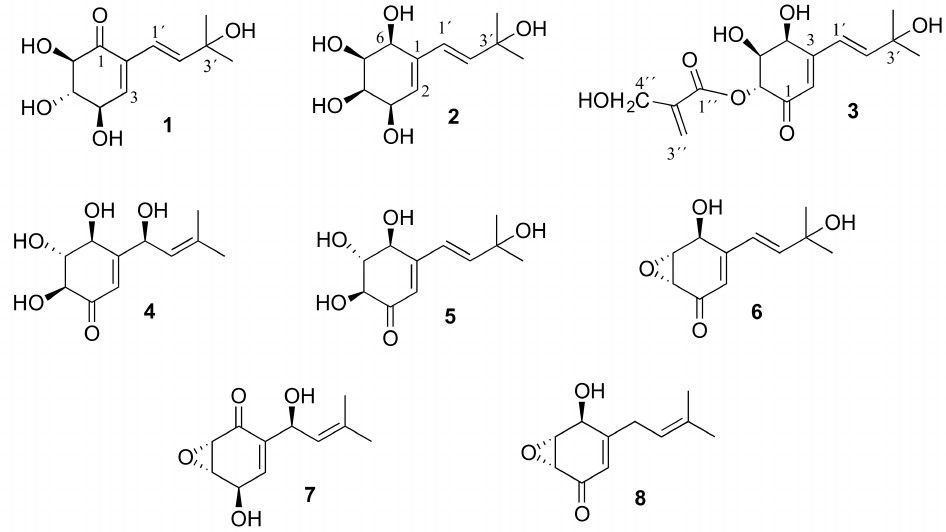
Figure 1. Structures of compounds 1 – 8 .